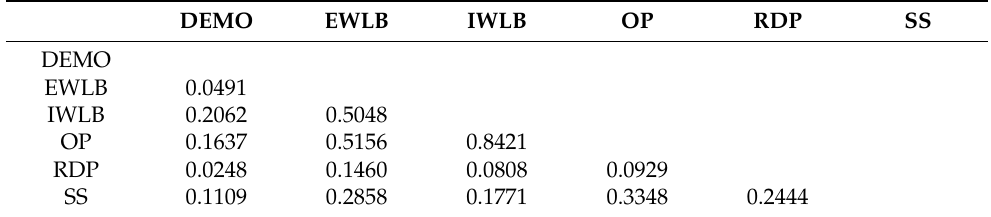
Table 6. Heterotrait-Monotrait Ratio (HTMT).